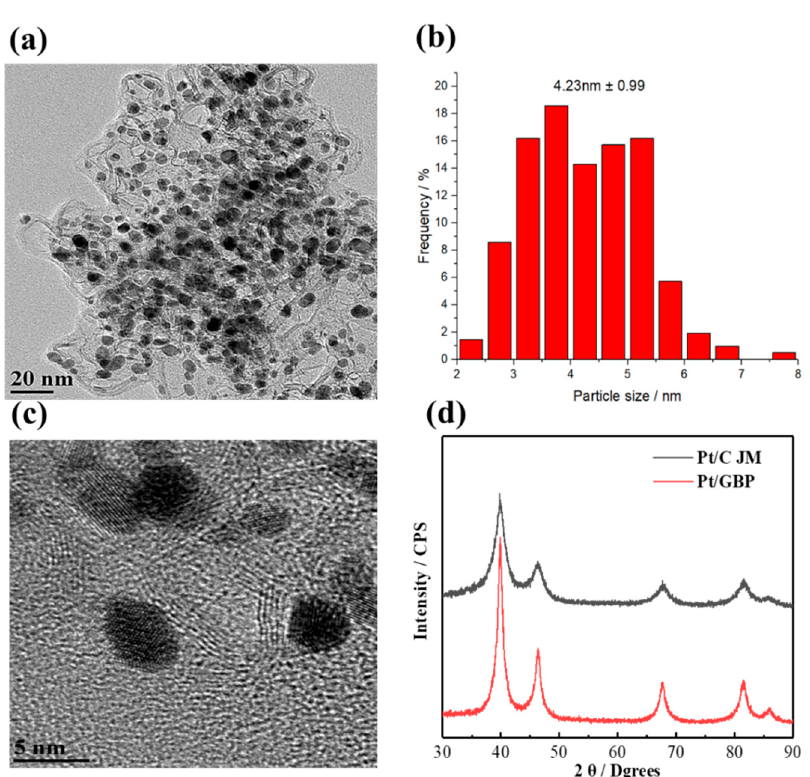
Figure 3. Pt/GBP catalyst: ( a ) the TEM image, ( b ) the histogram of particle size distribution, ( c ) the HRTEM image, and ( d ) the XRD spectrum compared with Pt/C JM catalyst.